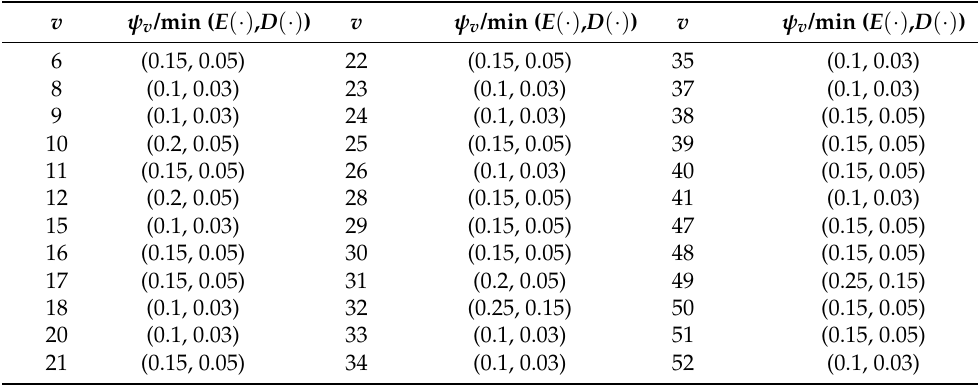
Table 7. The dissipation time of other vehicles at the